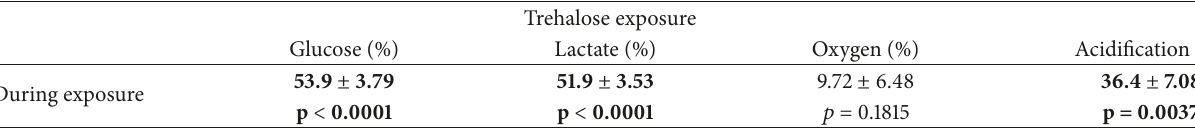
Table 7: Metabolic effects of trehalose exposure on macrophages. Mean peak MAMP height changes and standard errors for each experimental condition during exposure and recovery are shown. All 𝑝 values are calculated based on peak height versus 10min average basal value prior to exposure. Terms in bold are representative of 𝑝 < 0.05 , indicating statistical significance.